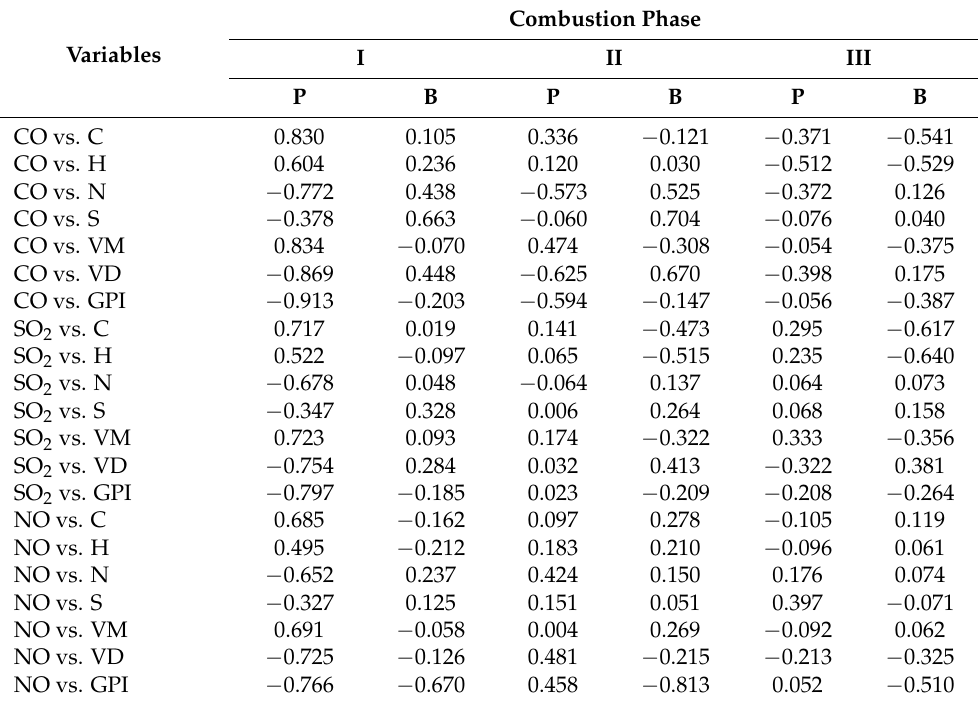
Figure 4. Emission NO in phase I, II, and III combustion. The relationships between the individual CO, NO, and SO 2 concentrations in the flue gas and the chemical composition of the tested biofuels expressed as Pearson’s correlations are shown in Table 3. Table 3. Pearson correlation coefficient for the relationship between combustion products and physic or chemical properties biofuels.